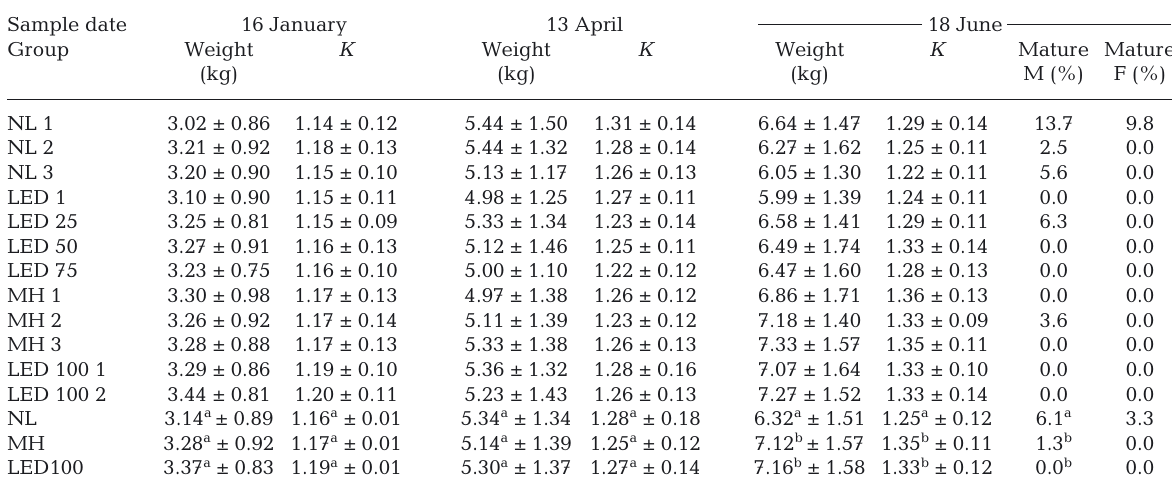
Table 1. Mean ± SD weight and condition factor (K) of Atlantic salmon Salmo salar given for each cage and treatment group in January, April and June, and incidence of sexual maturation (%) for males (M; mature fish gonadosomatic index, GSI > 0.4%) and females (F; mature fish GSI > 0.5%) for each cage registered at the June sampling. Significant differences within sample dates are noted by different superscript letters. The number of sampled fish per cage varied between 93 and 148. NL: natural light; LED 1, 25, 50, 100: light-emitting diode lamp dimmed down to a percentage (1, 25, 50 or 100%) of its maximum output; MH: metal halide